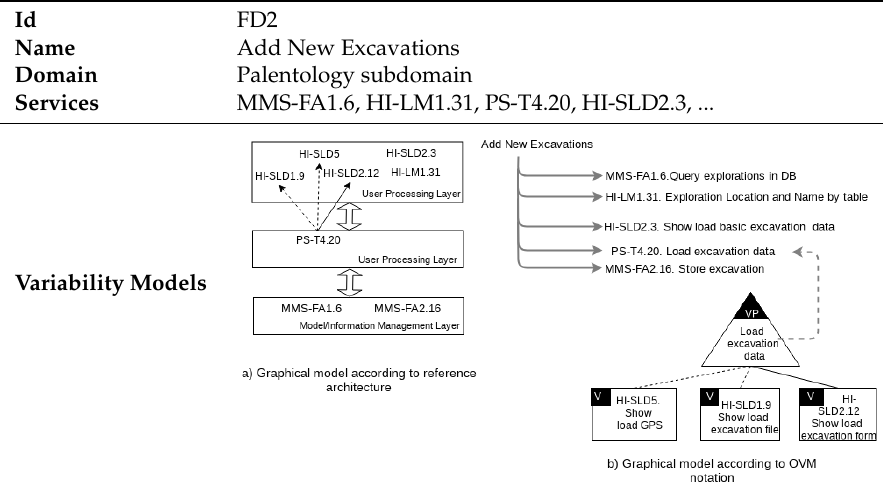
Table 1. An example of the functional datasheet for Add New Excavations .